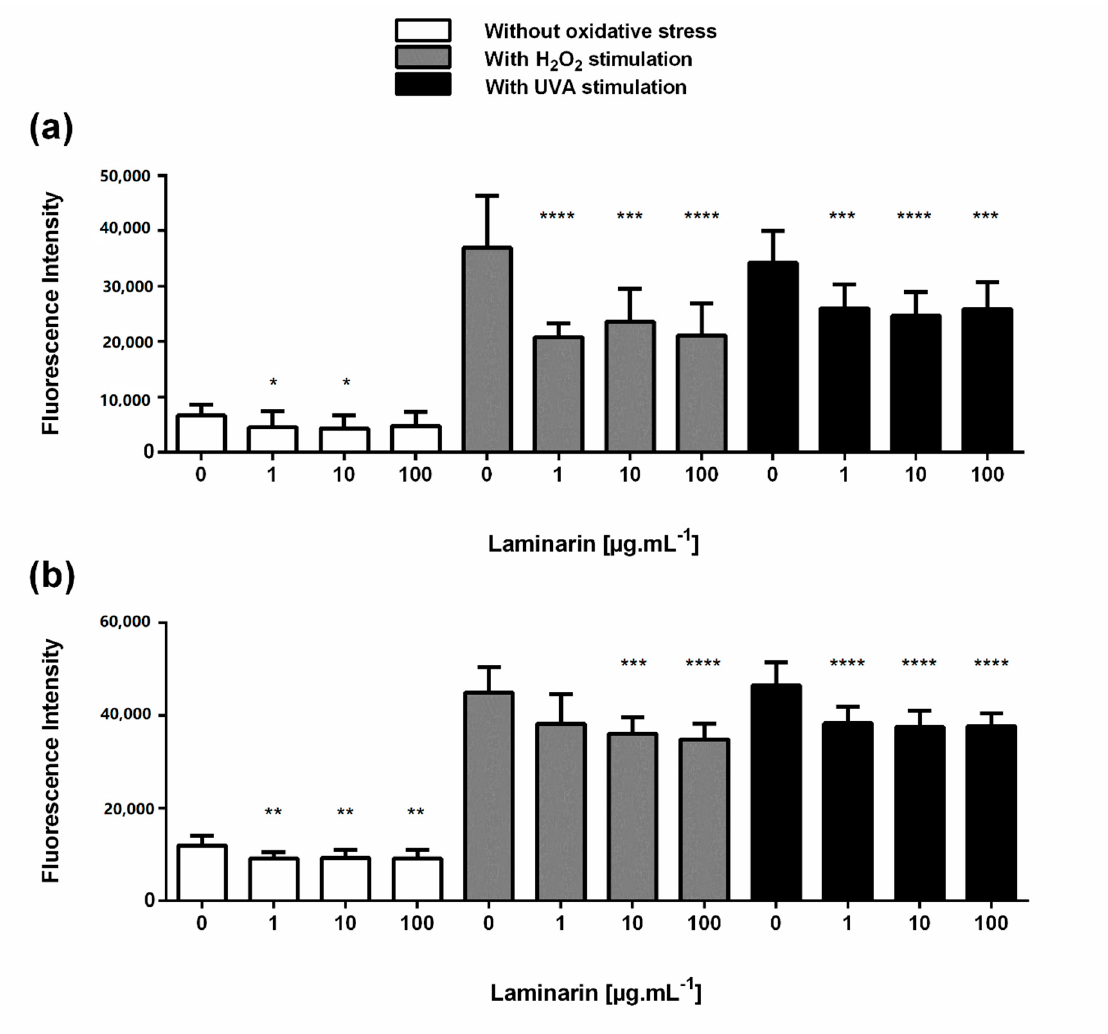
Figure 5. Effect of laminarin on oxidative stress. ( a ) HDFa and ( b ) NHEK cells were treated with 1, 10 and 100 µg.mL − 1 of laminarin for 4 h. ROS production was induced by 0.5 mM of H 2 O 2 or by 365 nm, 0.42 J.s − 1 .cm² of UVA radiation. Free radical scavenging activity was evaluated using a DCFH-DA probe. Data are expressed as mean ± SD of three independent experiments. * p ≤ 0.05, ** p ≤ 0.01, *** p ≤ 0.001, **** p ≤ 0.0001 compared with 0 µg.mL − 1 (control group).